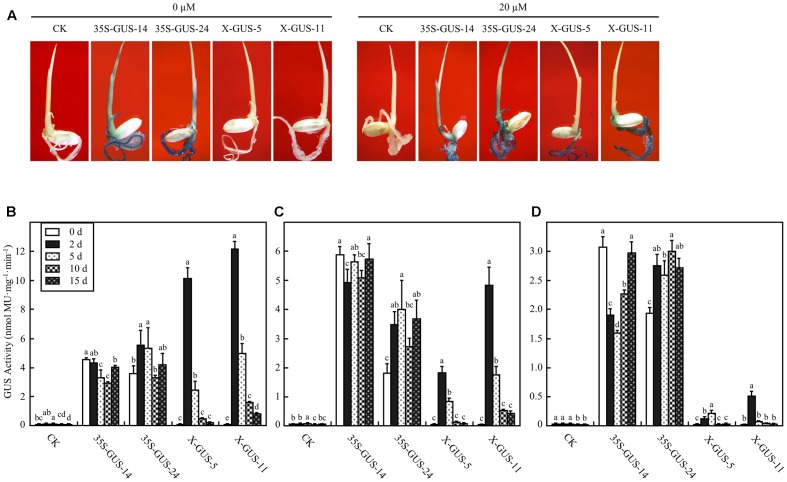
XVE-controlled GUS expression in intact transgenic rice seedlings treated with estradiol through root absorption. (A) GUS staining of rice plantlets exposed to 0 or 20 μM estradiol via root immersion for 2 days. CK, non-transgenic wild type control; 35S-GUS-14 and 35S-GUS-24, pCAMBIA1305-transformed rice line #14 and #24; X-GUS-5 and X-GUS-11, pUX-GUS-transformed rice line #5 and #11. (B–D) GUS fluorometric assay of the roots (B), stems (C), and leaves (D) of rice plantlets cultured in 0 or 20 μM estradiol via root immersion. Three-leaf-old seedlings of rice plants were cultured in liquid solution, and the roots, shoots, or leaves of the cultured seedlings were collected for GUS assay on days 0, 2, 5, 10, and 15, respectively. Different letters indicate groups with significant differences (ANOVA, p < 0.05).